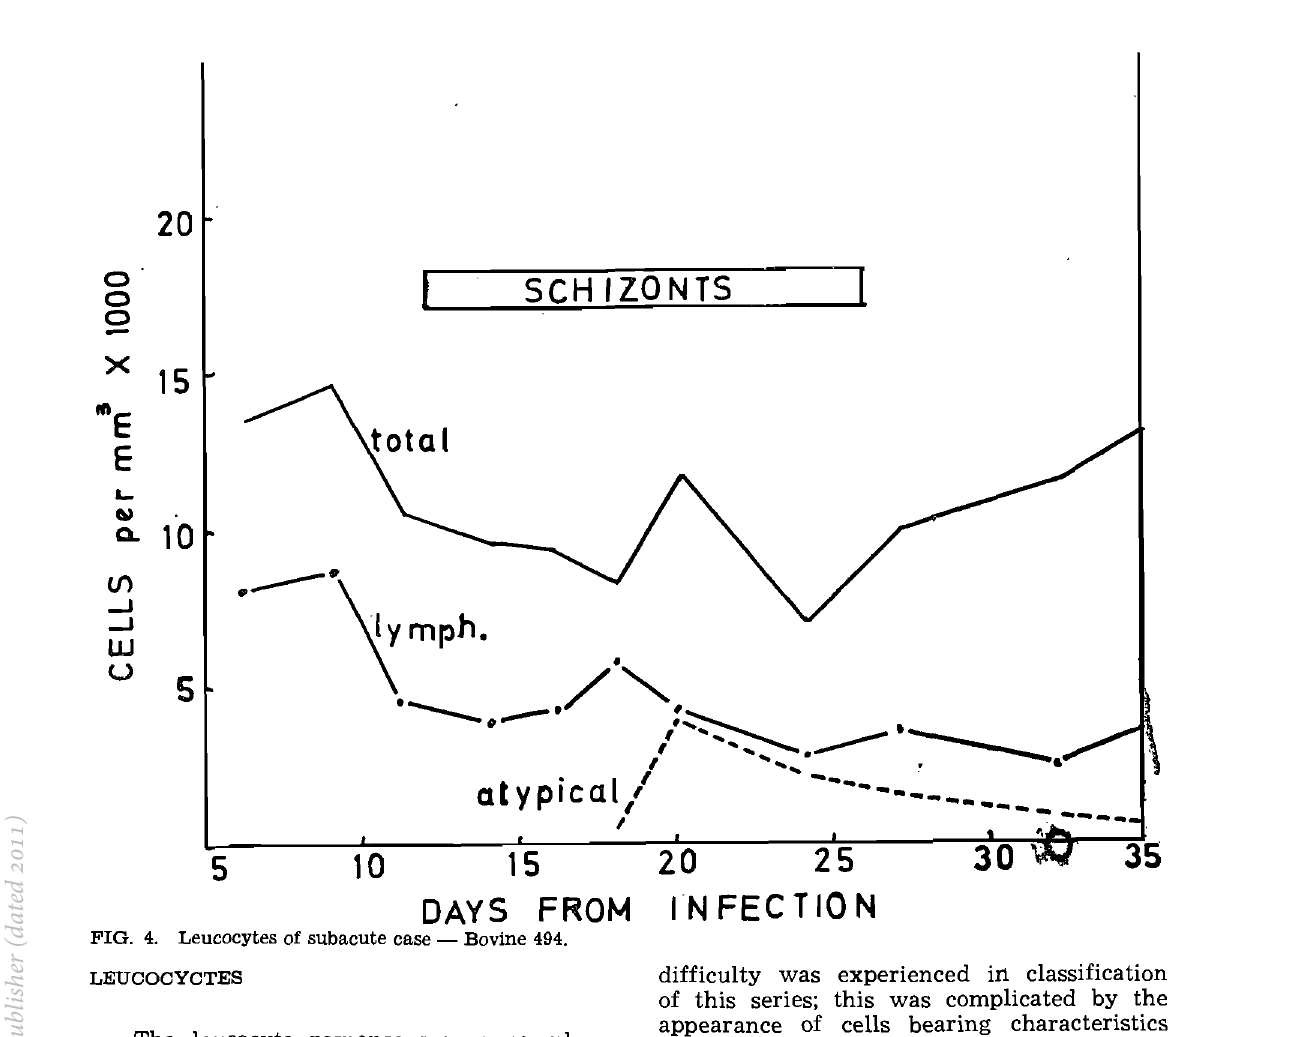
FIG. 4. Leucocytes of subacute case - Bovine 494.